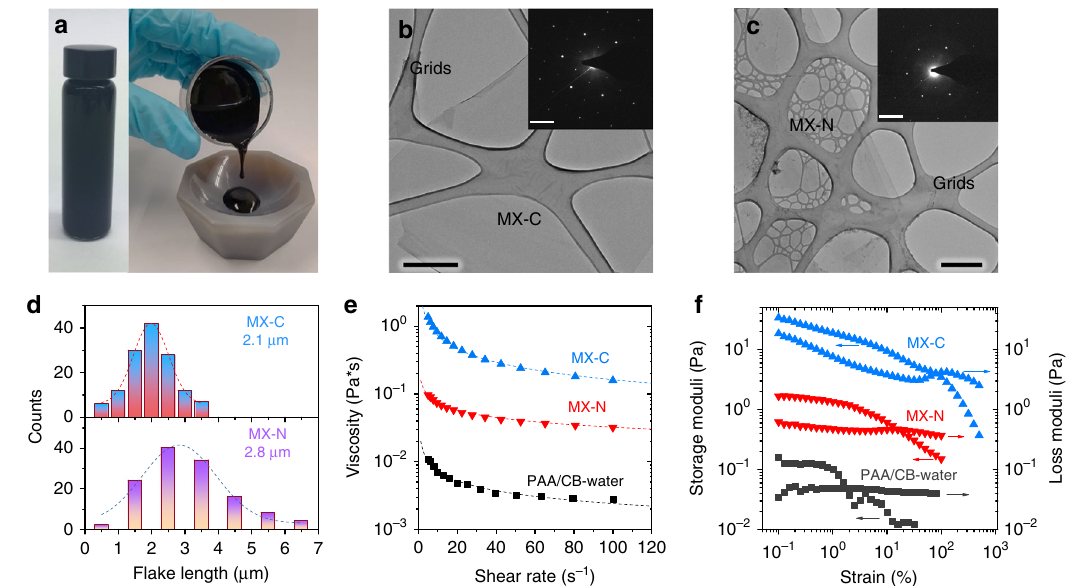
Fig. 1 Characterization of MXene inks. a Optical images of the MX-C ink, showing its viscous nature. Transmission electron microscopy (TEM) images of b MX-C and c MX-N nanosheets (scale bar for b and c = 500 nm). Insets are the corresponding selected area electron diffraction patterns of the nanosheets (scale bar = 5 nm − 1 ). d Histograms of MX-C and MX-N fl ake lengths obtained via TEM statistics. e , f Rheological properties of MX-C and MX- N inks with e viscosity plotted as a function of shear rate and f storage and loss moduli plotted as a function of strain. Also included is the control sample made of PAA (aqueous binder) and carbon black (CB) dispersed in water